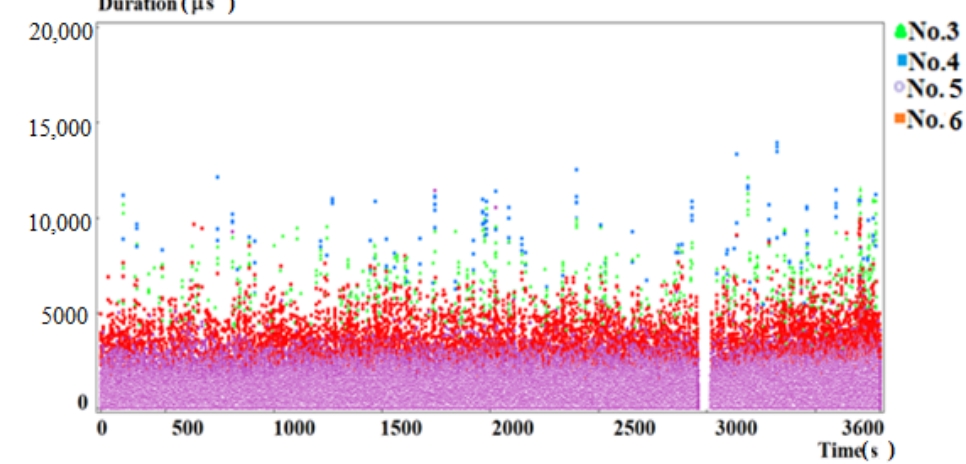
Figure 22. Signal duration versus time for three measurements.